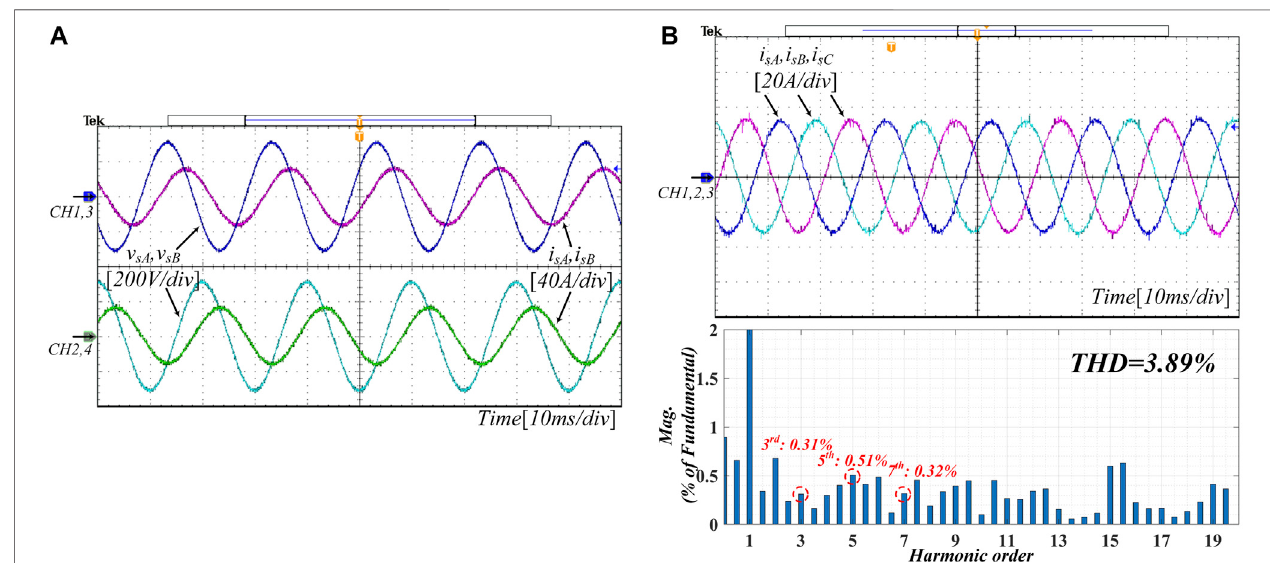
FIGURE 13 | Experiment waveforms of grid voltage and output current; (A) Grid voltage and output current of phase A and B; (B) Three phase output current and frequency spectrum of i sA (cut off at